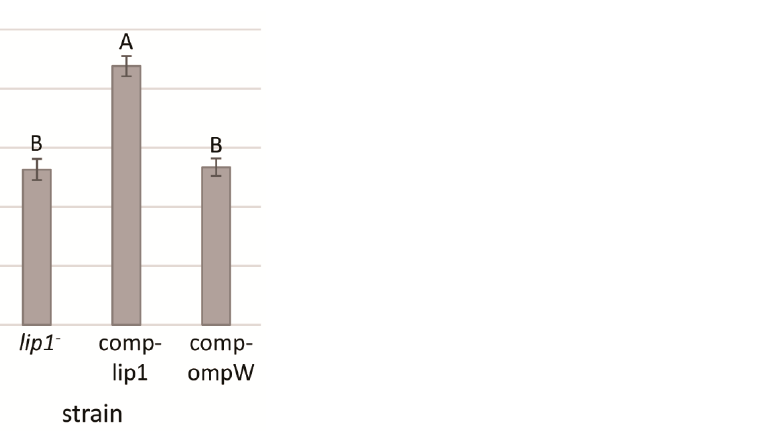
11 of 19 Figure 4. Length of twitching haloes of A. citrulli M6, the M6- lip1 - mutant, and M6- lip1 - carrying plasmid pBBR-MCS-5 expressing lip1 or ompW (M6-comp-lip1 and M6-comp-ompW, respectively). Bacteria were grown for 48 h on NA plates at 28 °C, and twitching haloes around the colonies were measured from 30 colonies per strain. Data represent averages and standard errors (SE) from one experiment, out of three with similar results. Different letters indicate significant differences ( p < 0.05) among treatments by Tukey–Kramer and ANOVA. 3.5. The M6-lip1 - Mutant Has Reduced Virulence Relative to Wild-Type M6 Acidovorax citrulli is a seed-borne pathogen and melon seedlings are highly susceptible to the pathogen [2]. Therefore, we carried out seed transmission assays to assess whether lip1 contributes to A. citrulli virulence. Disease severity was evaluated 10 days after inoculation (d.a.i), using a scale based on seedling weight [36]. Seedlings emerging from seeds that were inoculated with the M6- lip1 - mutant exhibited significantly